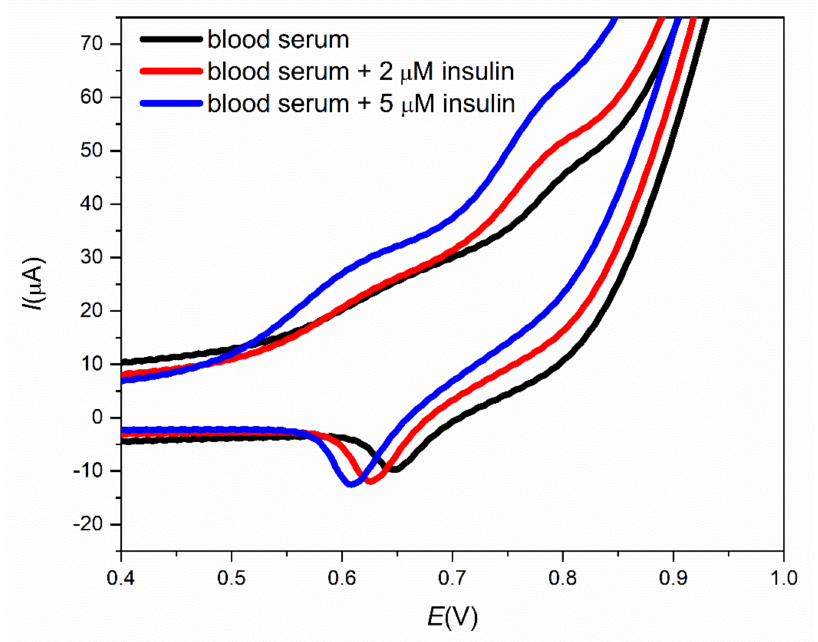
Figure 12. Cyclic voltammograms for the pure blood serum and blood serum samples with 2 µ M and 5 µ M